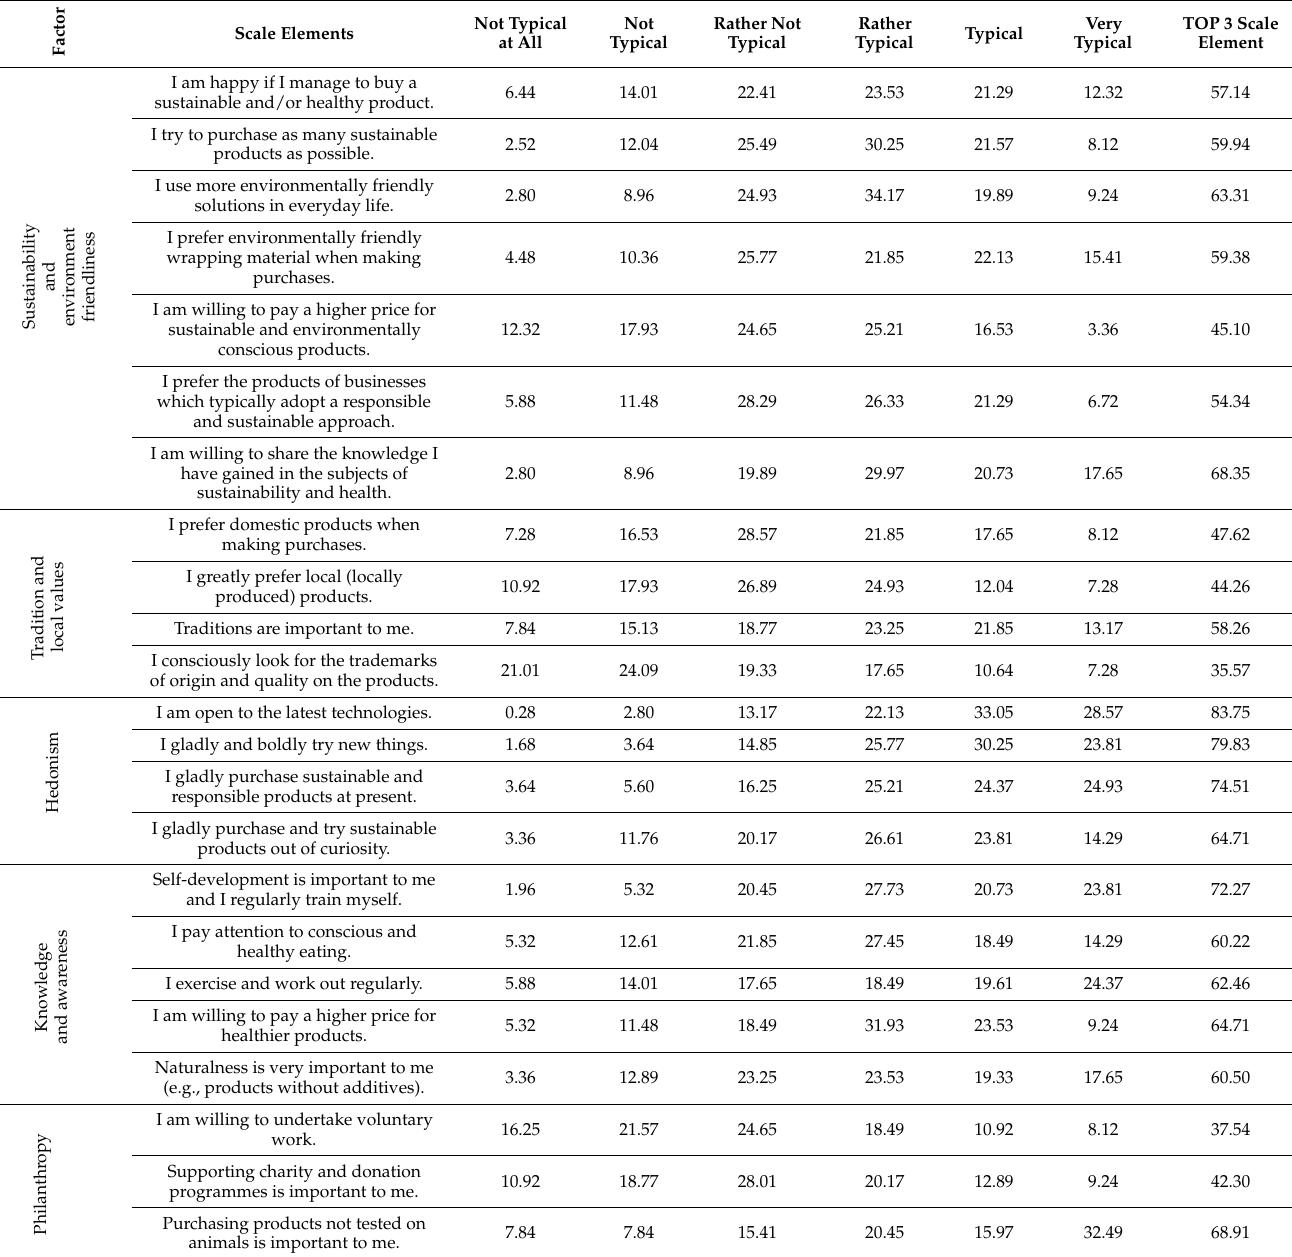
Table 3. Frequency of answers for the LOHAS model scale elements